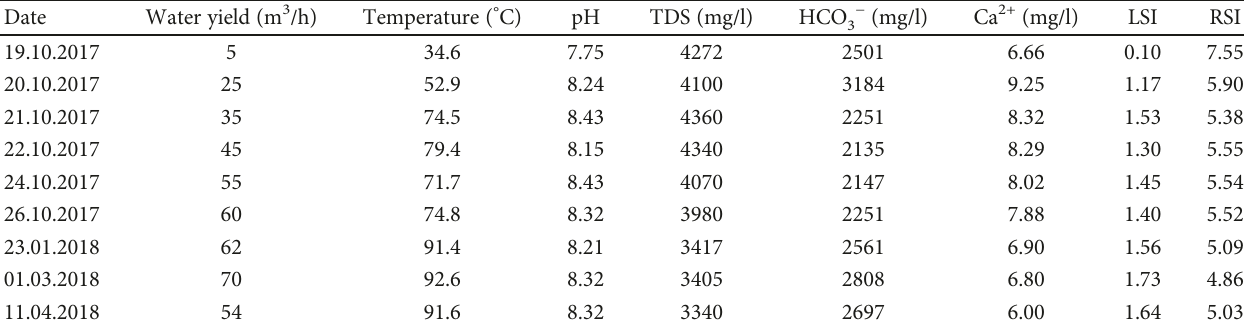
CO (l/m 3 ) 167 199 5 72 2